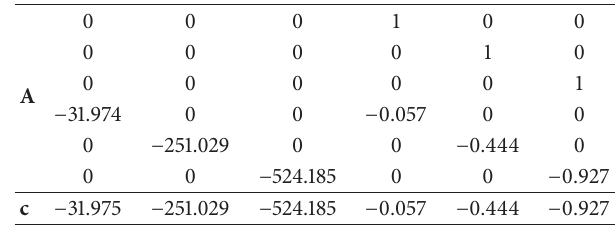
Table 6: System matrices A and c of the typical state space model for Case 1 .